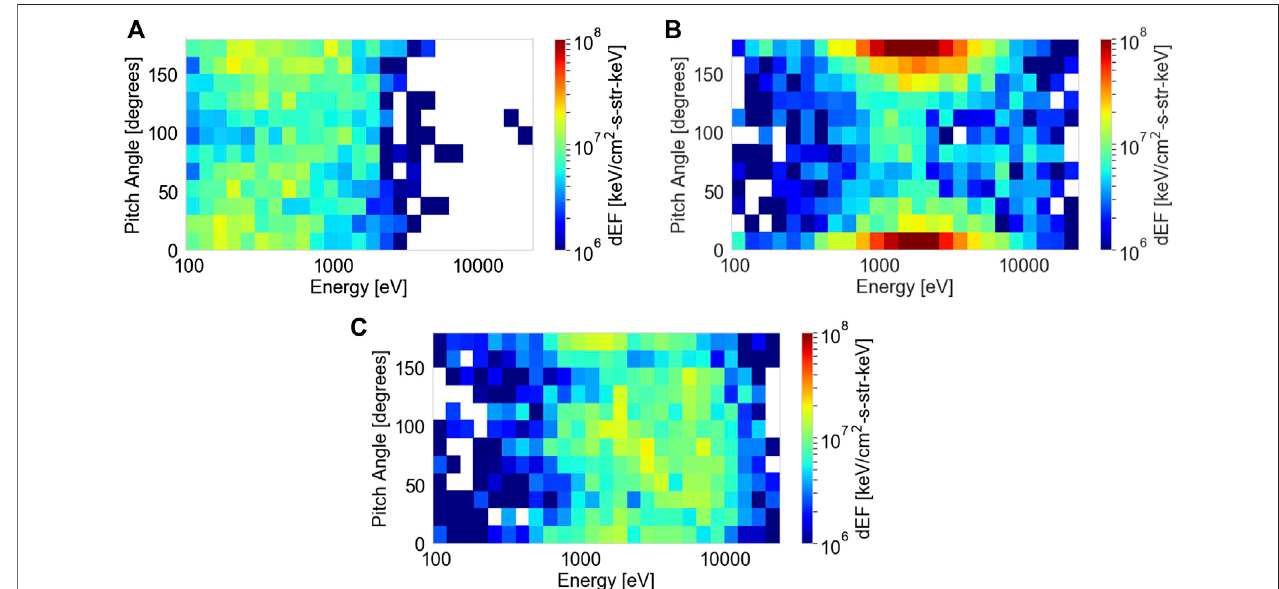
FIGURE 4 | The evolution of a tearing distribution into an isotropic distribution with a higher bulk energy. The differential energy fl ux distributions as a function of pitch angle and energy, which correspond to the times (A) (23:27:13 UT), (B) (23:34:23 UT), and (C) (23:34:41 UT) in Figure 3 as measured by the C4 PEACE